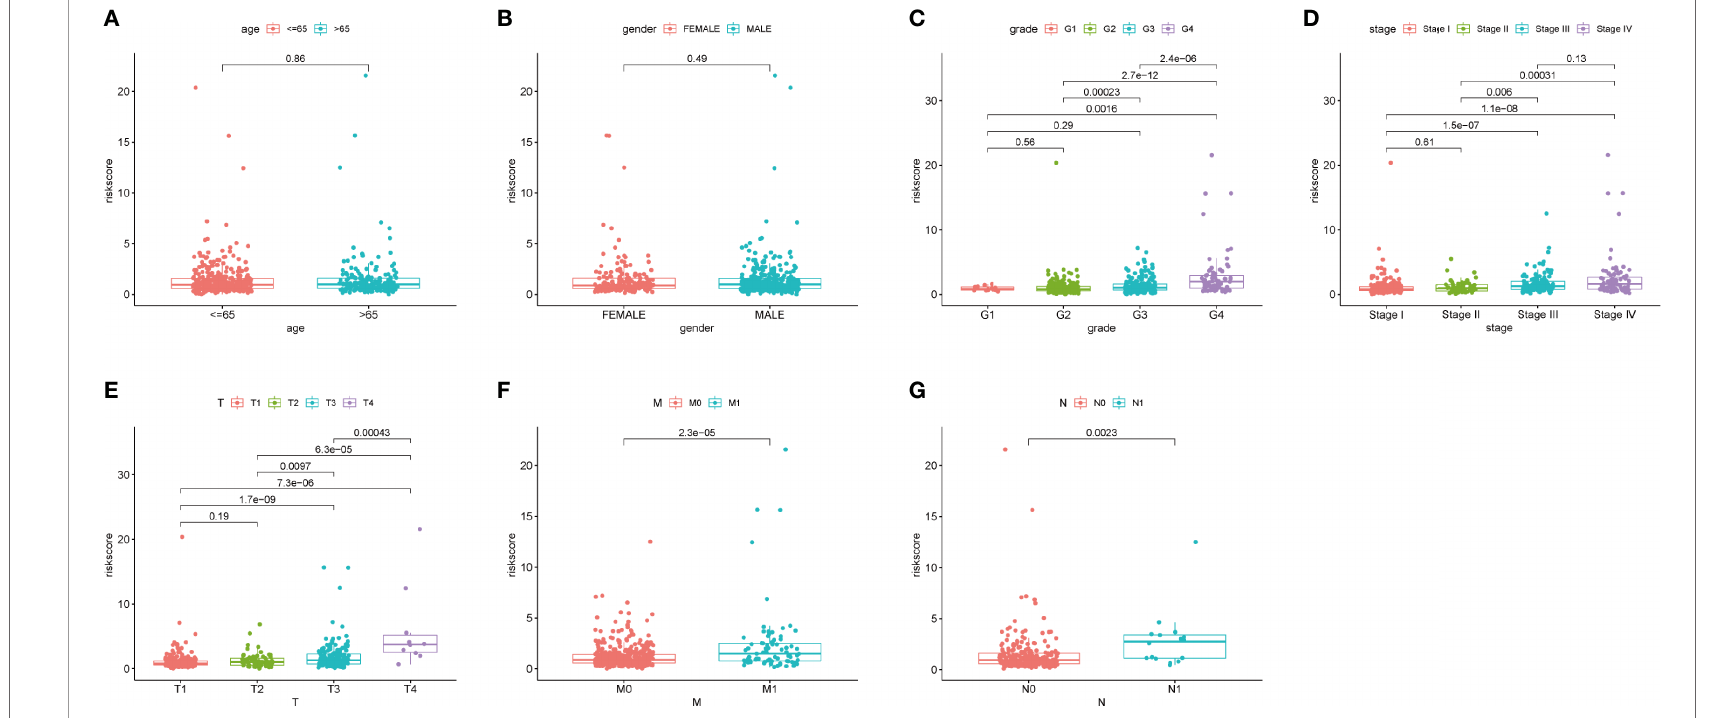
FIGURE 2 | Correlation analyses of the ferroptosis-related genes prognostic signature with various clinicopathological characteristics of the ccRCC patients. According to (A) Age ( ≤ 65 y vs. >65 y); (B) Gender (male vs. female); (C) Grade (G 1/2; G3/4); (D) Stage (stage I/II; stage III/IV); (E) T stage (T1/2; T3/4); (F) M stage (M0 vs. M1); (G) N stage (N0 vs. N1) for analysis and